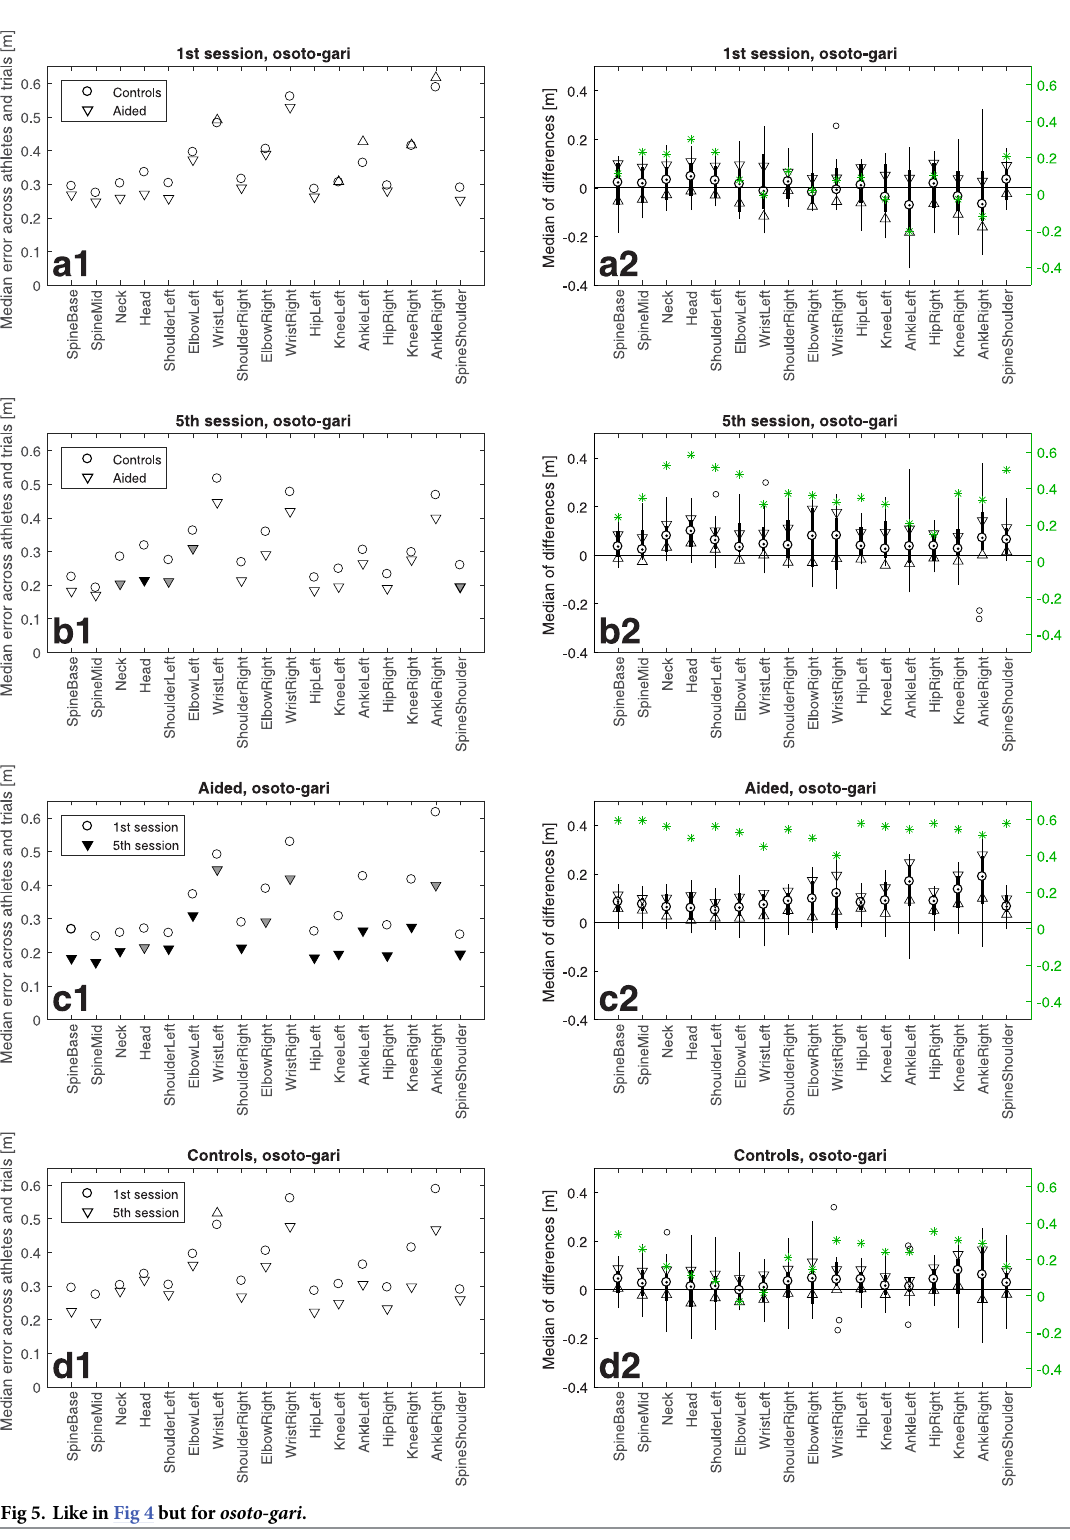
Fig 5. Like in Fig 4 but for osoto-gari